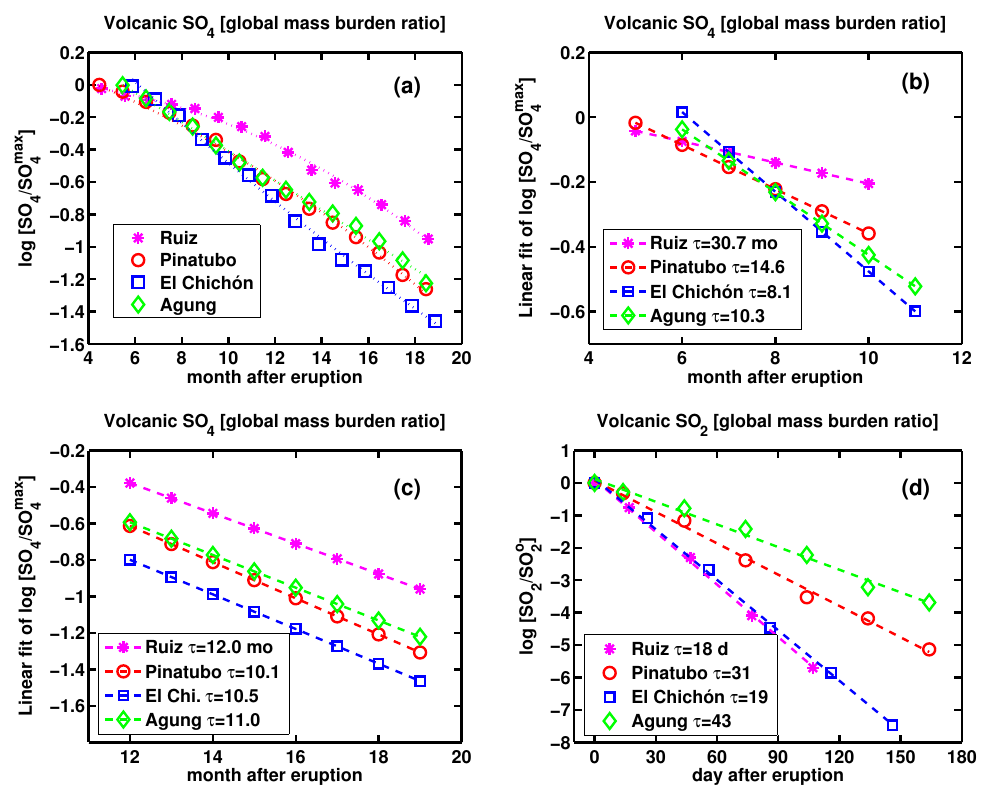
Figure 10. Panels ( a – c ): time series of volcanic SO 4 , as globally integrated mass burden ratio with respect to its maximum value, reached 5–6 months after each eruption (see legend for the line styles adopted for the tropical eruptions considered in this study). Panel ( a ) shows the ULAQ-CCM-calculated values up to approximately 19 months after each eruption; panels ( b ) and ( c ) show the values obtained from a linear fit in the time frame of post-eruption months 4–10 (or 5–11) in ( b ) and months 12–19 in ( c ). In the legends of panels (b–c) the calculated e- folding times of volcanic SO 4 are presented. Panel ( d ) is similar to ( b ), but in this case the globally integrated SO 2 mass burden ratio with respect to its initial value is shown, as from the ULAQ-CCM calculations. In the legend, the calculated e- folding time of volcanic SO 2 is presented (referring to the decay in the sulfate global mass